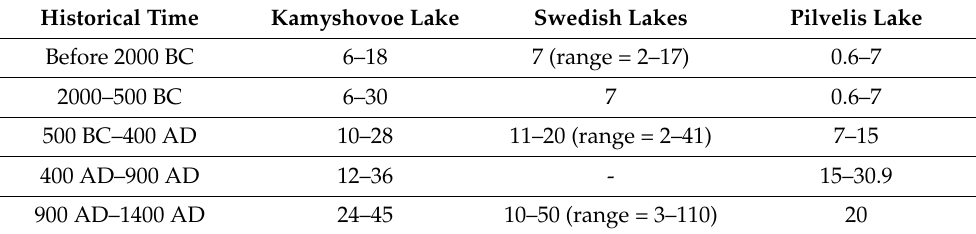
Table 3. Pb concentration (ppm) in the sediments of Kamyshovoe Lake (min and max values within interval), Swedish lakes (mean value and range within different lakes) and Pilvelis Lake (Latvia) during different historical times